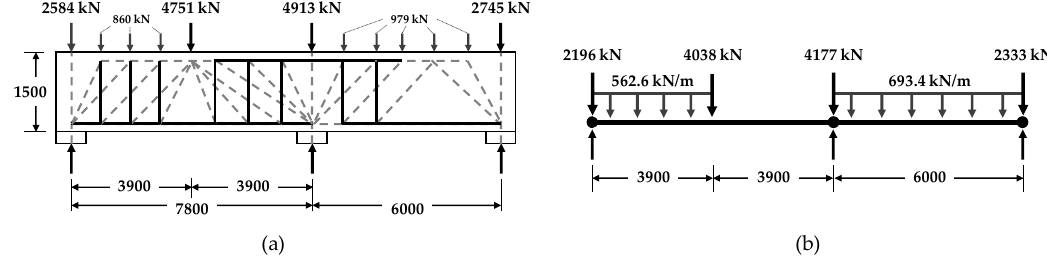
Figure 2. Analysis method for the design of transfer girder (redrawn from Ko and Lee [9]). ( a ) Strut-tie model and ( b ) Line element